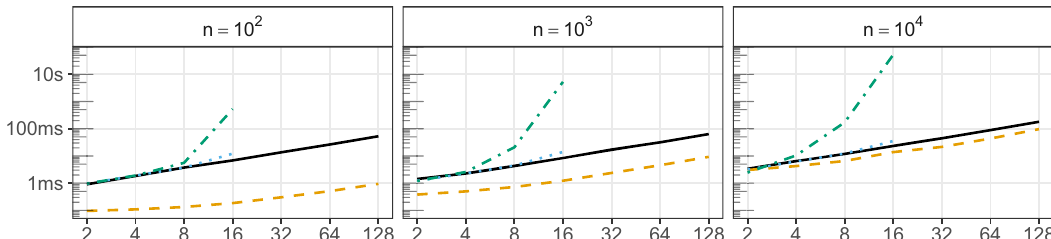
Figure 5: The median runtime of the MDCM ( solid, black ) , LFM ( dashed, yellow ) , AM ( dotted, blue ) , and ESM ( dash - dotted, green ) algorithms for an extMO distribution from the exponential family with drift and without killing, calibrated to unit exponential margins and a bivariate lower - tail dependence coe ffi cient of 50%. We measured the AM ’ s and ESM ’ s runtimes for ≤ d 16 .